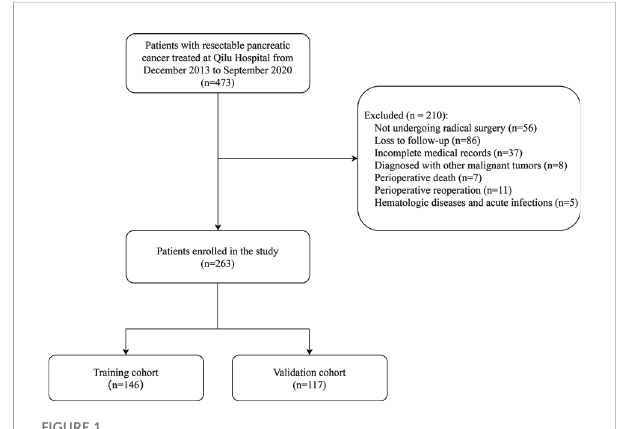
FIGURE 1 The fl owchart of enrolled